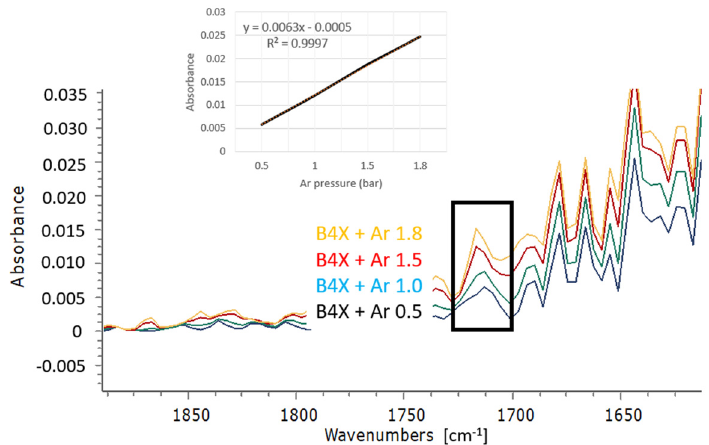
Figure 7. Exemplification of the effect of a broadening gas (Ar) on the intensity of a weak peak of an LNG sample (named B4X) at 1716 cm − 1 (attributed to CH bending). The inset shows the ratio of variation of the signal as a function of the pressure of Ar. The pressure of the sample was always 0.2 bar, whereas the total pressure is indicated in the labels.